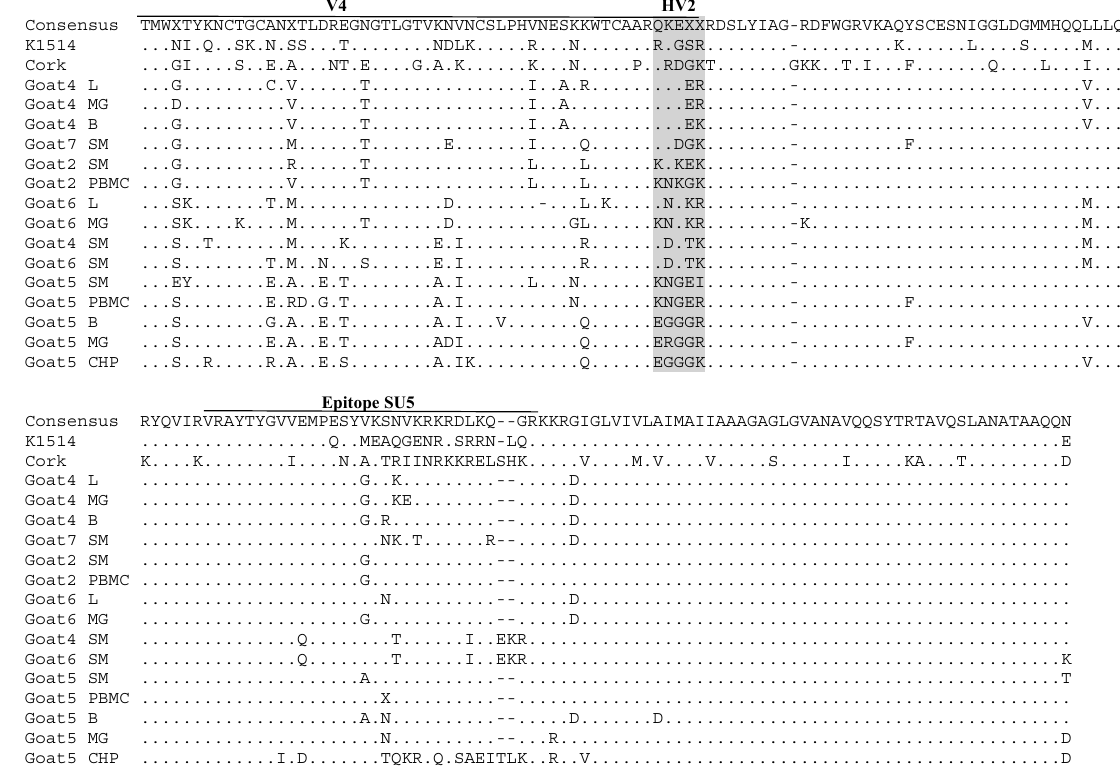
Figure 5. Alignment of deduced amino acid sequences of an immunodominant epitope of the ENV protein and variable region V4 of SRLVs obtained in this study and reference strains. Deletions are indicated by a dash (-), and identical residues are indicated by dots (.). PBMC—Peripheral blood mononuclear cells, L—Lung, SM—Synovial membrane, B—Brain, CHP—Choroid plexus, MG—Mammary gland.